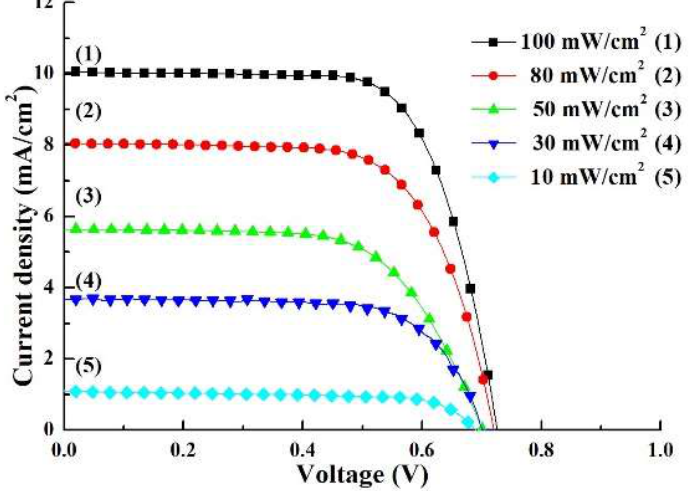
Figure 12. Current density–voltage curves of the DSSC based on TANLP under different illuminations.